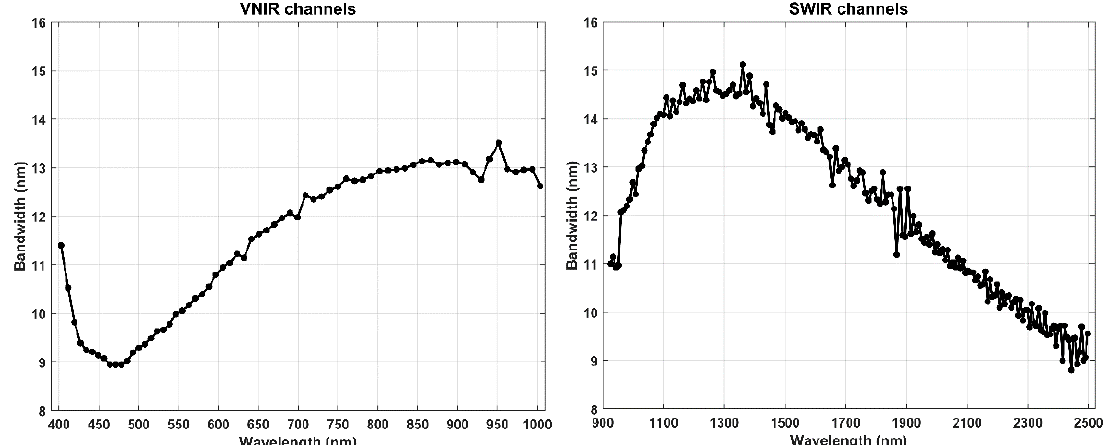
Figure 3. Channels and bandwidth of the PRISMA sensor: VNIR on left and SWIR on right.